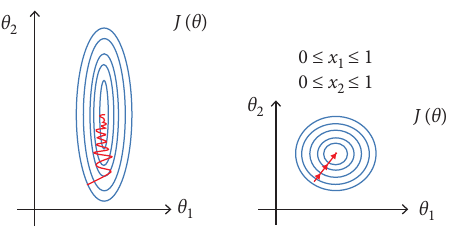
Figure 7: Feature scaling and contour